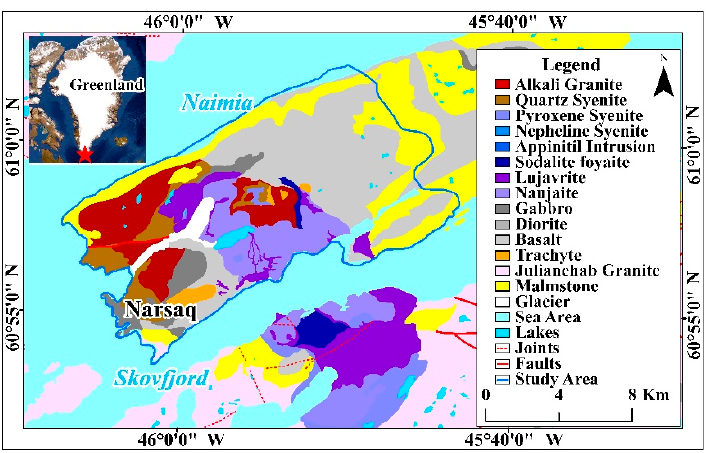
Figure 2. Geological map of the study area.